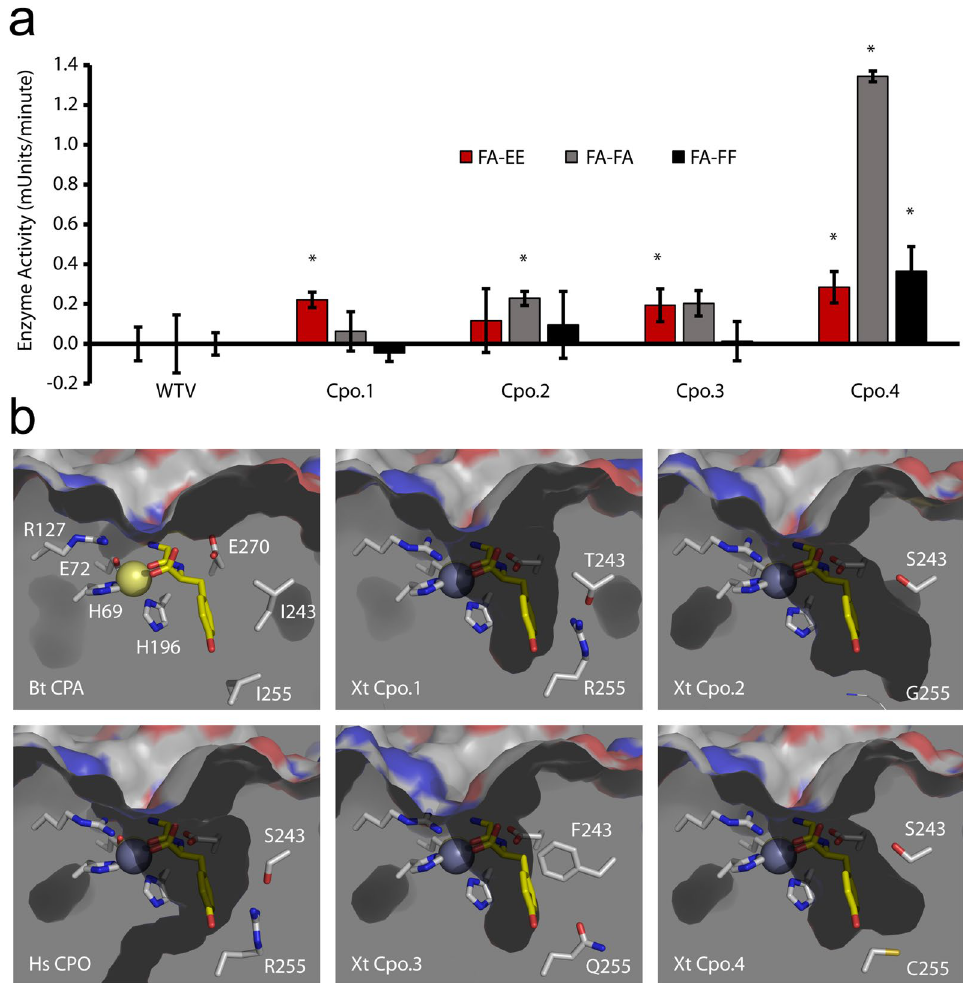
Figure 7. Xenopus tropicalis CPO orthologs exhibit different substrate preferences. ( a ) One hundred microliters of each trypsinized media was incubated with 900 µl of 0.5 mM substrate (FA-EE, FA-FA, FA-FF, pH 7.5) at room temperature. Change in absorbance at 340 nm was measured over time and the rate of reaction shown as the change in absorbance (milli-absorbance-units) per minute. n = 3–6. Error bars indicate standard deviation. * p < 0.05, comparing to the corresponding WTV dataset, as determined by ANOVA and Tukey– Kramer post-hoc analysis. ( b ) Each Xenopus tropicalis CPO paralog was modeled with AlphaFold2 and aligned in Pymol with X-ray crystal structures for Bos taurus CPA (3CPA) and Homo sapiens CPO (5MRV, chain a). All images show the zinc cofactor from Hs CPO as a gray sphere, the zinc cofactor from Bt CPA as a yellow sphere (largely superimposed by the gray sphere) and the Gly-Tyr dipeptide bound to the active site of Bt CPA as a yellow stick model. Key active site residues from each structure are indicated. Cavity surfaces, as viewed from the inside of the protein and with the prodomains removed, are shown in dark grays, while the protein outer surface is shown with white carbons, red oxygens, and blue nitrogens. No substrate binding pocket is shown for Bt CPA, as the pocket is filled with the Gly-Tyr and so not rendered as a